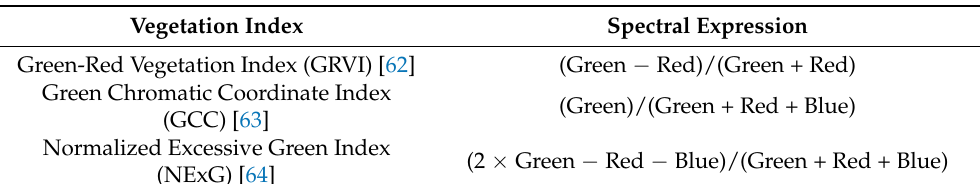
Table 1. The VIs used in this study with their respective spectral equations. These VIs were calculated using their respective spectral equations, by using red, green, and blue reflectance values recorded by the RGB sensor of the UAS. By applying these equations to the aerial imagery, it is possible to obtain information regarding the plant’s health status, such as chlorophyll content and leaf area index.